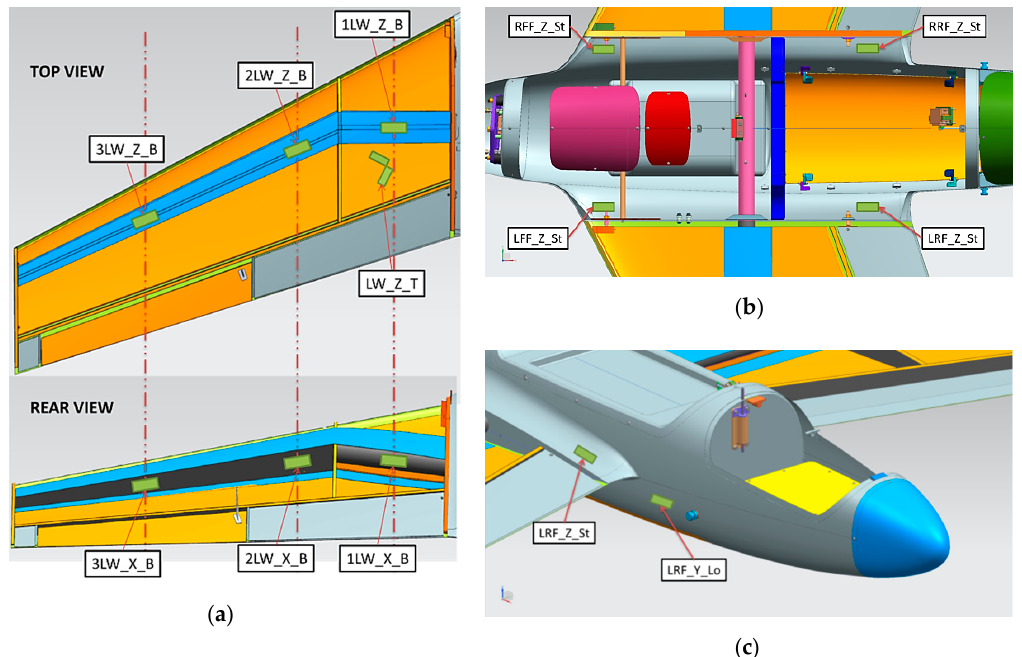
Figure 12. Strain gauges location ( a ) on the wing, ( b ) on the top fuselage and ( c ) on the side